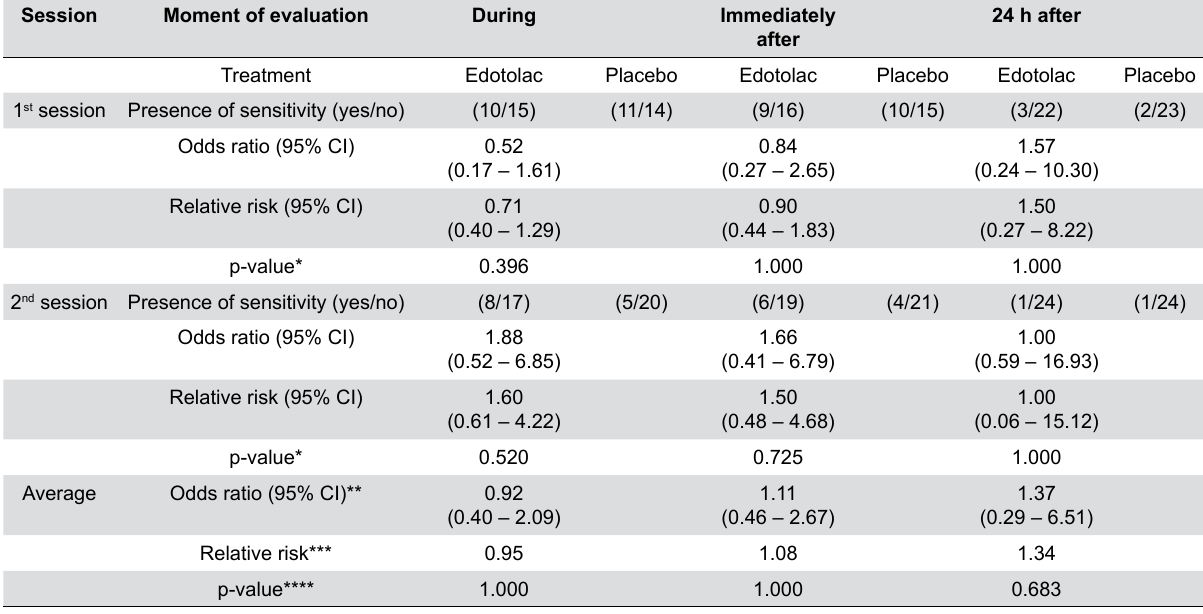
Table 2- Results of risk of tooth sensitivity observed for each